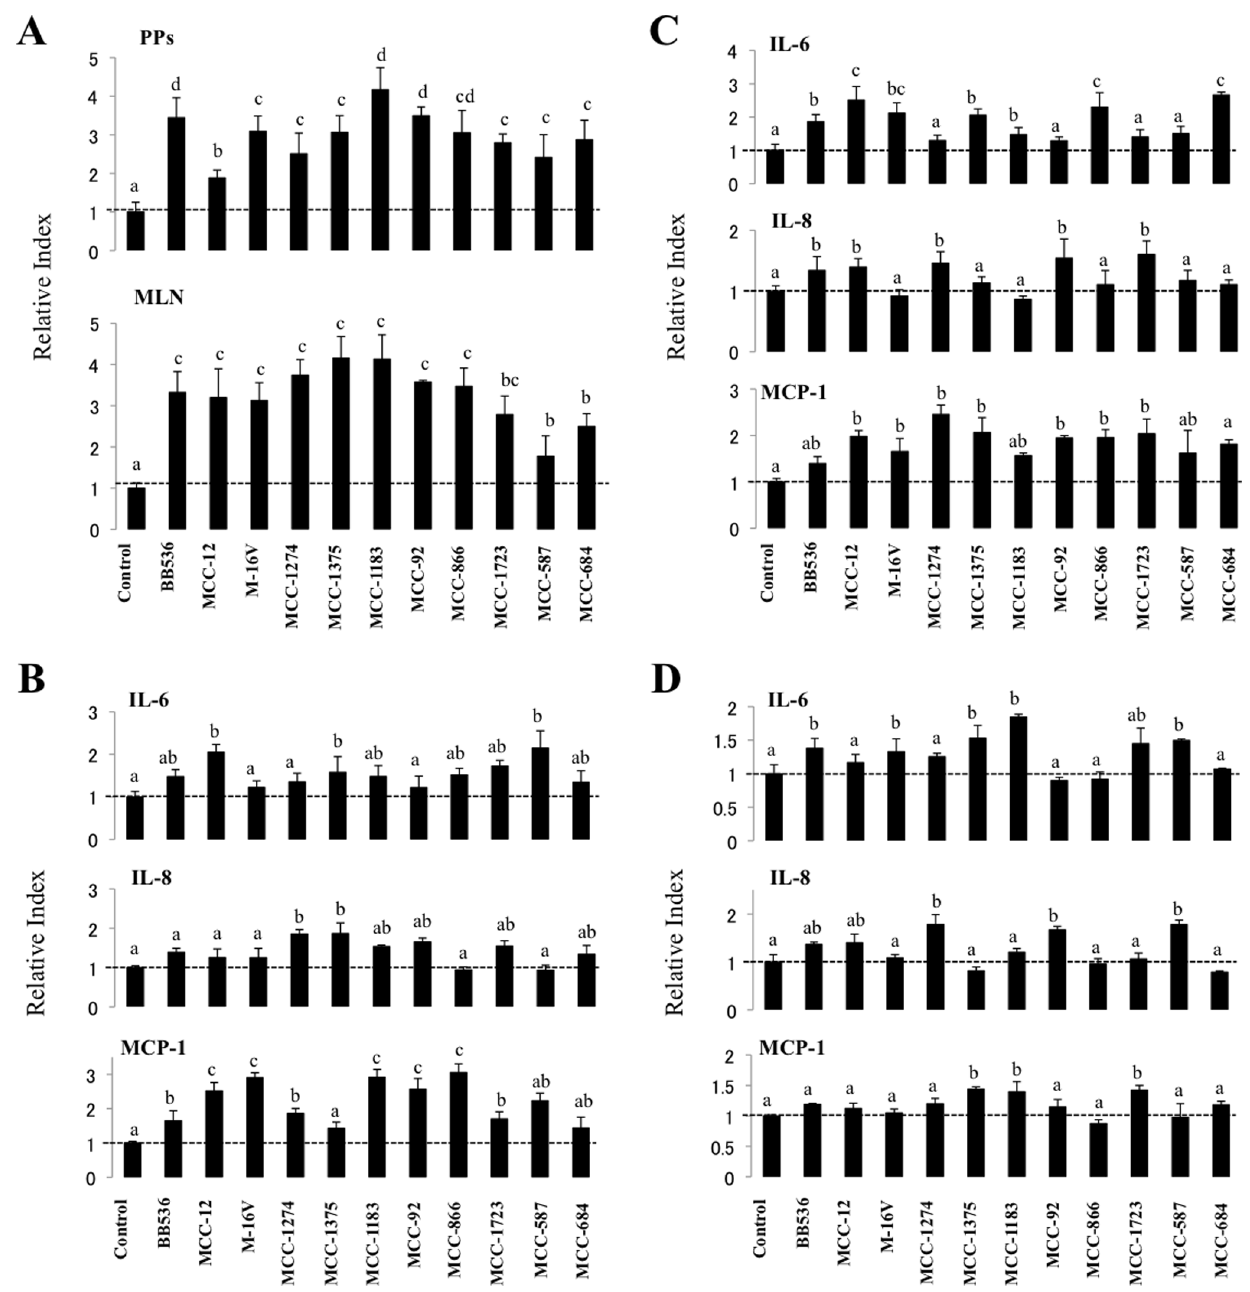
Figure 1. Selection of bacterial strains with immunomodulatory capacities. Bacteria were evaluated by studying (A) the mitogenic assay and expression of cytokines in porcine Peyer_$B!G_(Bs patches (B), mesenteric lymphoid nodes (C), and porcine intestinal epithelial cells (D). Cells were pre-treated with different bacterial strains for 48 h, and then the mitogenic activity or the expression of MCP-1, IL-6, and IL-8 were measured. The results represent four independent experiments. Different letters indicate significant differences (P , 0.05).